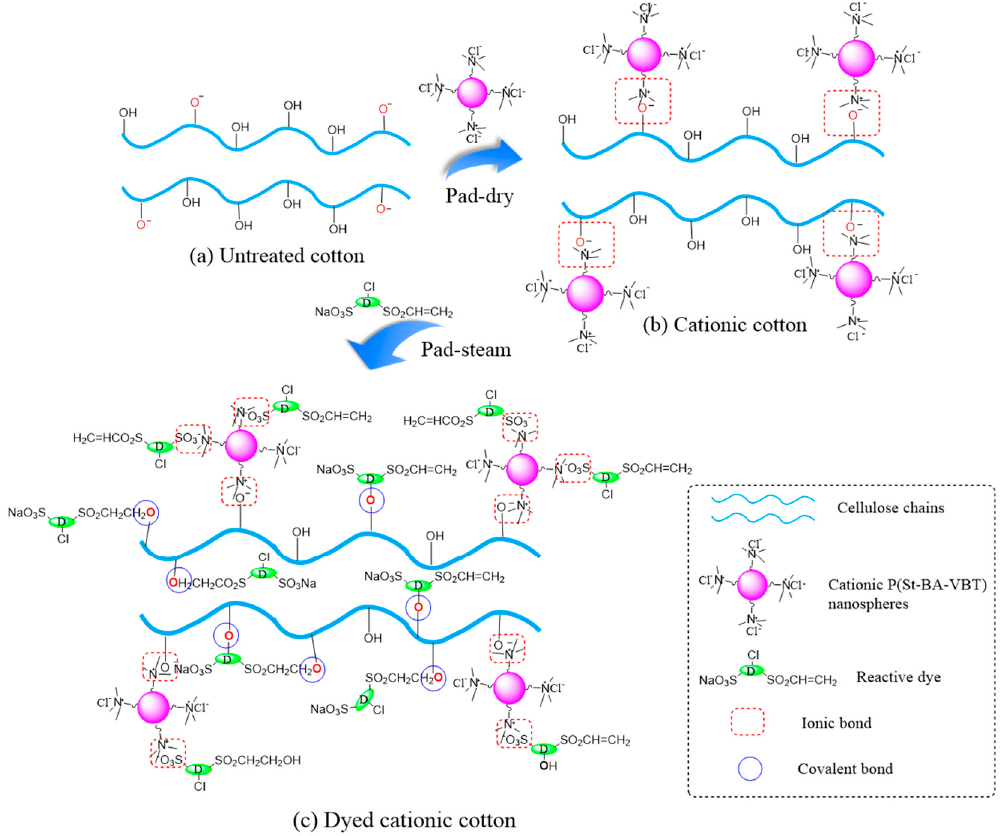
Figure 4. The mechanism of nanospheres modification and reactive dyeing of cotton fabrics: ( a ) untreated cotton; ( b ) cationic cotton and ( c ) dye cationic cotton.